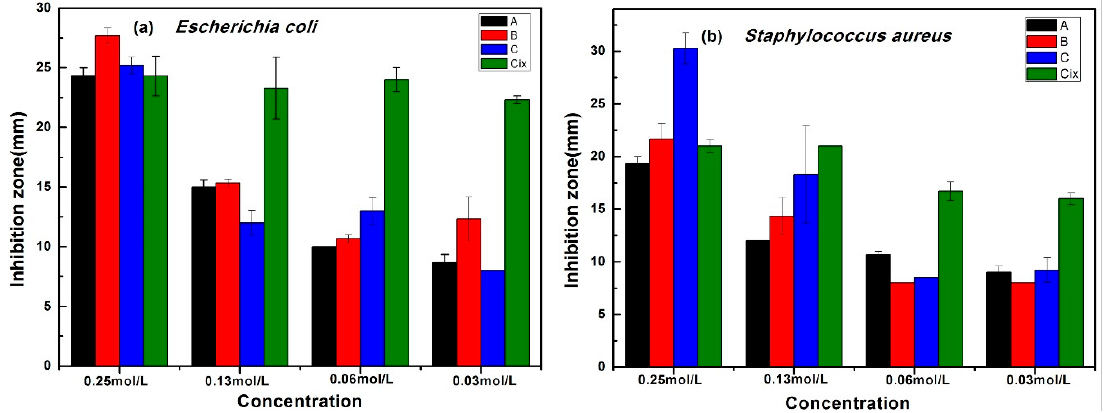
Figure 5. The inhibition zone of the screened compounds against E. coli ( a ) and S. aureus ( b ).